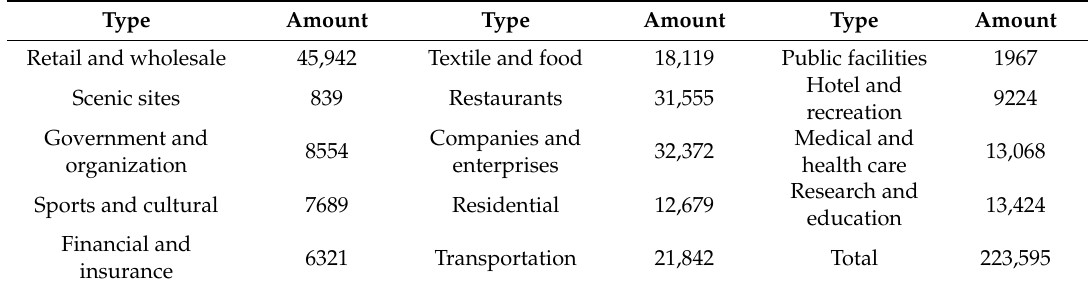
Table 1. Number of points of interest (POIs) at each category.